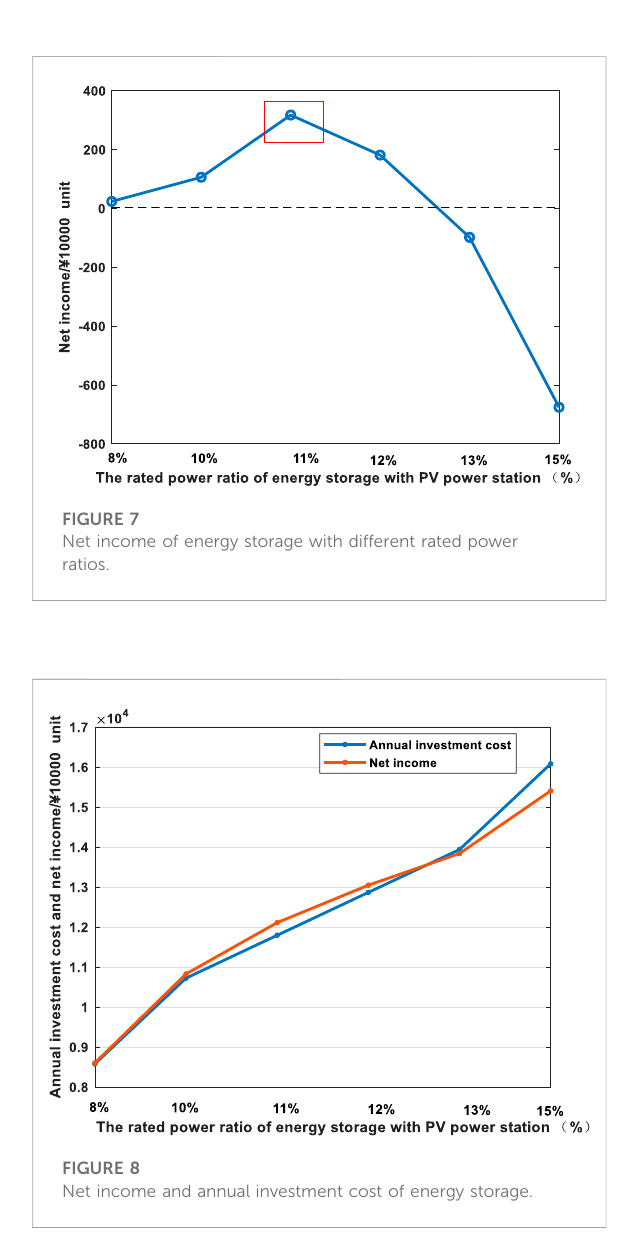
FIGURE 8 Net income and annual investment cost of energy